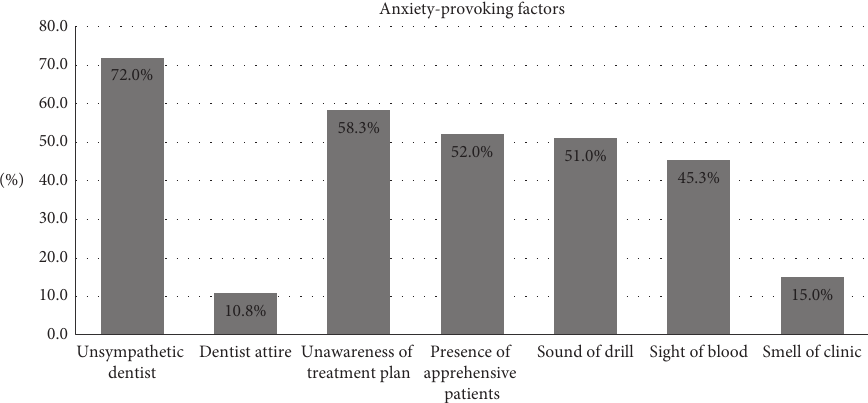
Figure 1: Percentage distribution of dental anxiety-provoking factors in clinical setting according to the response of